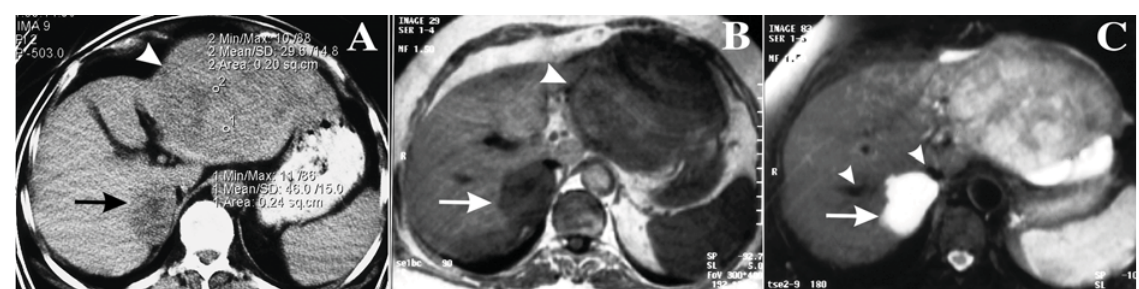
Figure 1. (A) A preoperative CT of the liver. Tumors in left lateral segments (white arrowhead) and segments VII-VIII (black arrow) are shown. (B) A preoperative T1-weighted MRI. (C) A preoperative T2-weighted MRI. Note the relations of the tumor in segments VII-VIII (arrow) with the right hepatic vein and vena cava